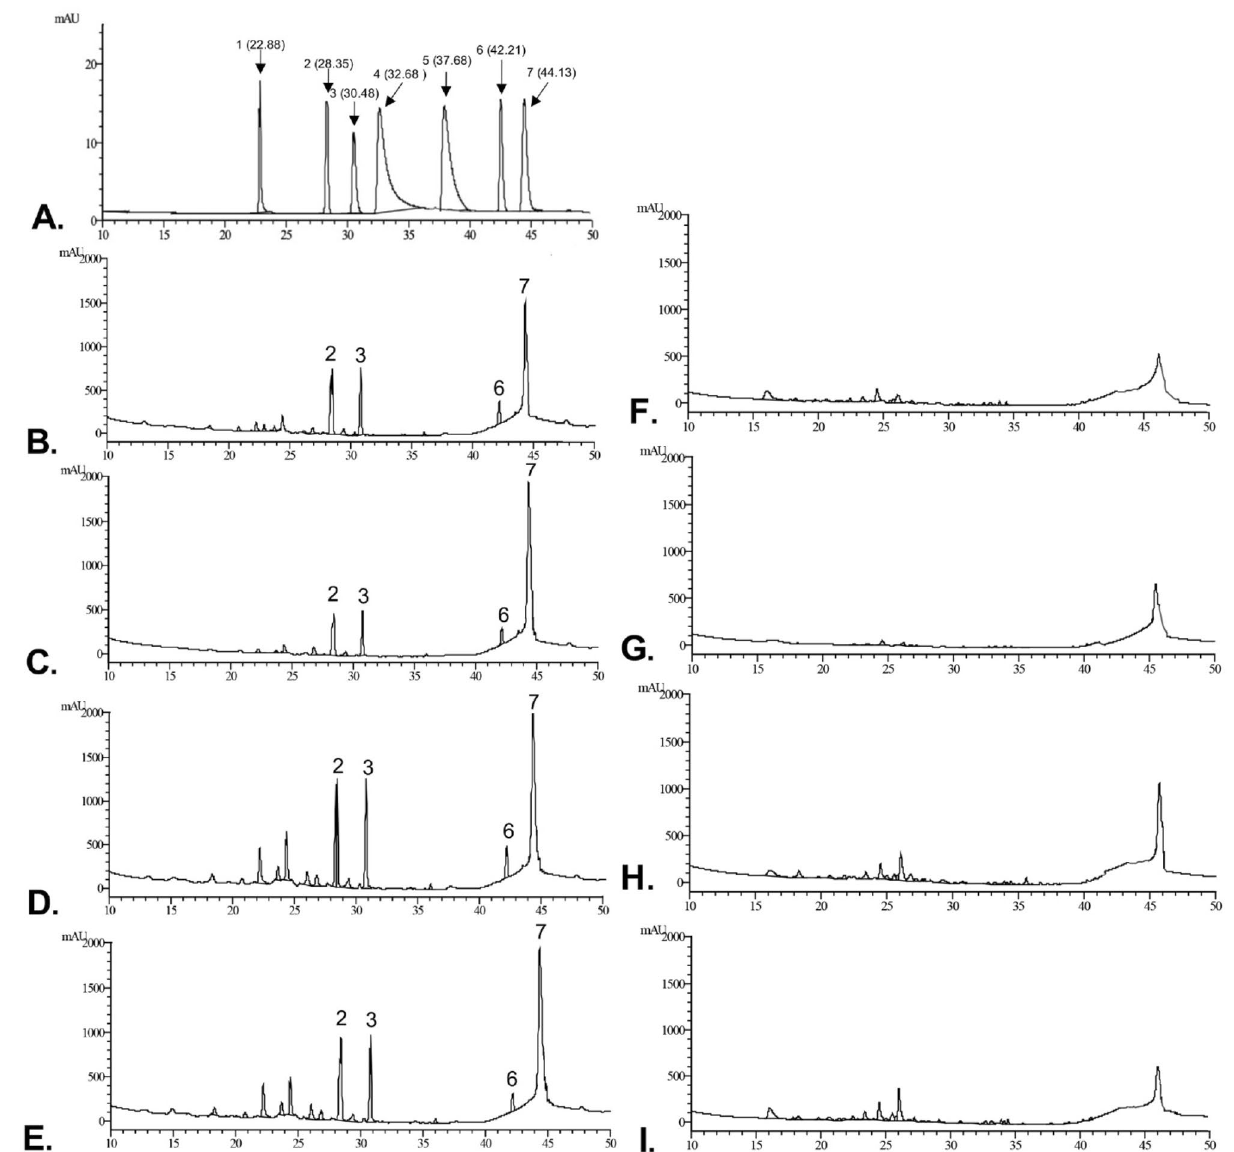
Figure 3. Centella extract from callus culture has unique chemical profiles. HPLC chromatogram of ( A ) standard solutions of triterpenes and flavonoids ( 1 , rutin; 2 , madecassoside; 3 , asiaticoside; 4 , quercetin; 5 , kaempferol; 6 , madecassic acid; 7 , asiatic acid); ( B–E ) Authentic plant extract ( B, methanol; C, 95% ethanol; D, 70% ethanol, E , 50% ethanol); and ( F–I ) Callus extract ( F, methanol; G, 95% ethanol; H, 70% ethanol, I , 50% ethanol). The retention time (RT) was shown in